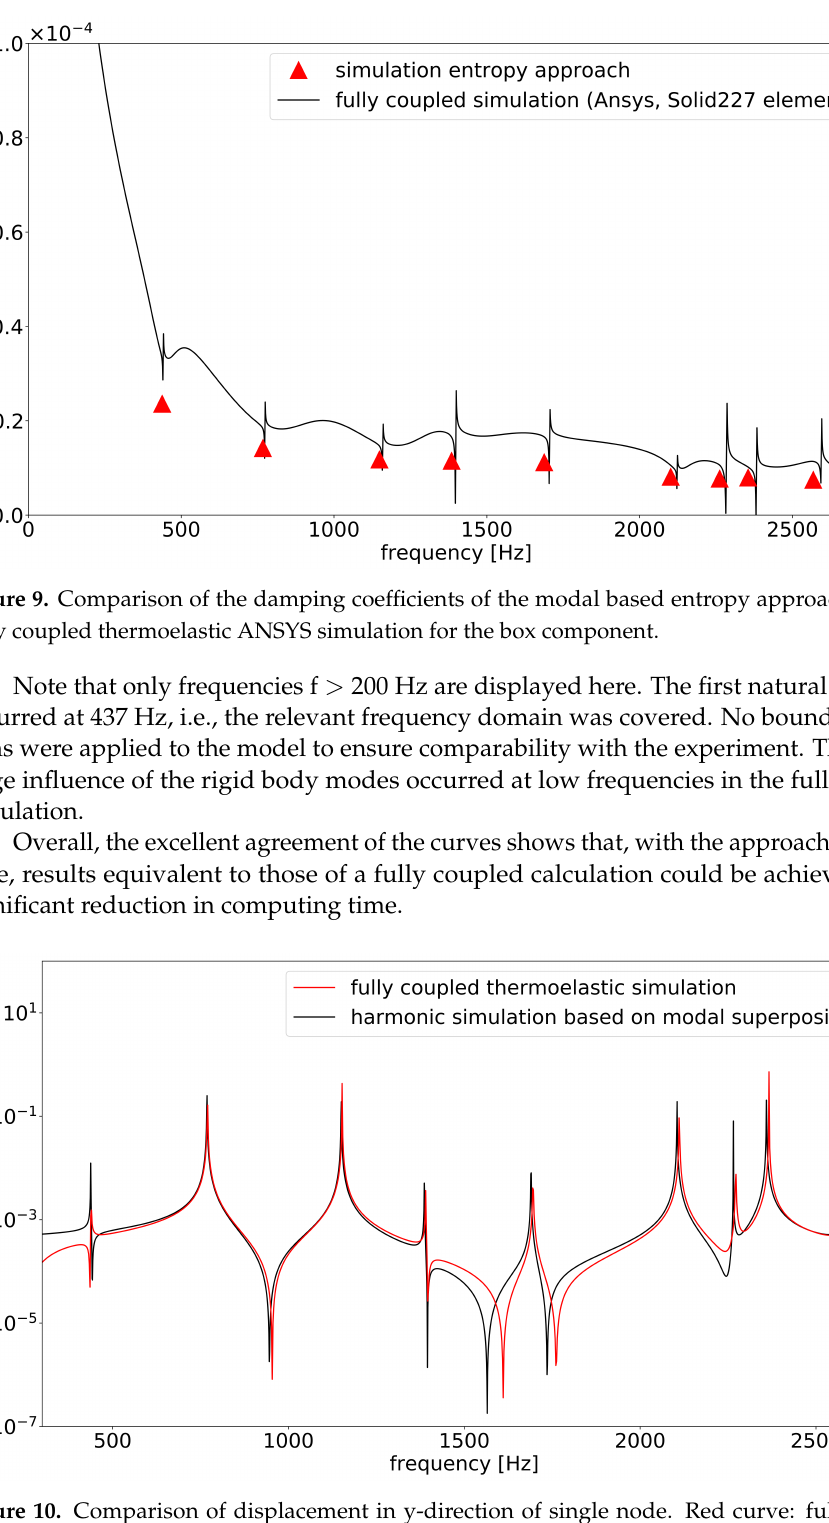
Figure 10. Comparison of displacement in y-direction of single node. Red curve: fully coupled simulation with thermoelastic elements SOLID226. Black curve: harmonic simulation based on modal superposition, use of modal damping coefficients that were calculated with the entropy